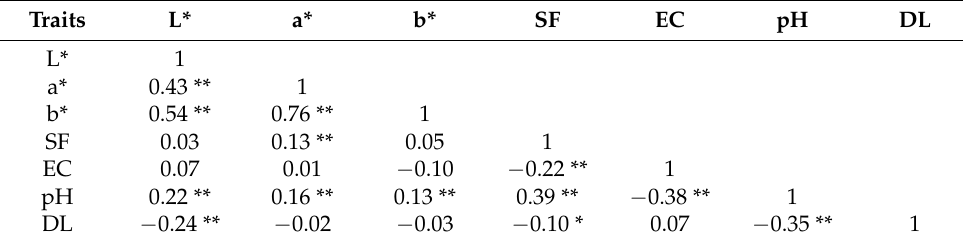
Table 4. Correlation coefficients (r) among the meat quality traits of Wuliang Mountain Black-bone